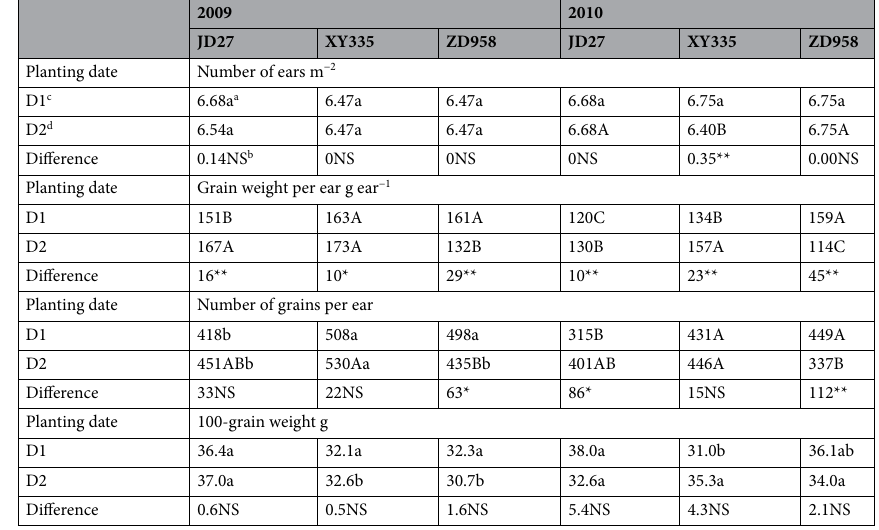
Table 5. Effects of planting date and hybrid maturity on number of ears m -2 , grain weight per ear, number of grains per ear, and 100-grain weight of dryland corn at Lishu city, Northeast China during 2009 and 2010 growing seasons. a Means within a row followed by a different lower-case letter differ at P < 0.05. Means within a row followed by a different upper-case letter differ at P < 0.01. b NS, not significant. c D1 represents the planting date of maize in early May. The planting dates for 2009 and 2010 were May 2 and May 4, respectively. d D2 represents the planting date of maize in mid-May. The planting dates for 2009 and 2010 were May 12 and May 14, respectively. * Significant at the 0.05 level. ** Significant at the 0.01 level.